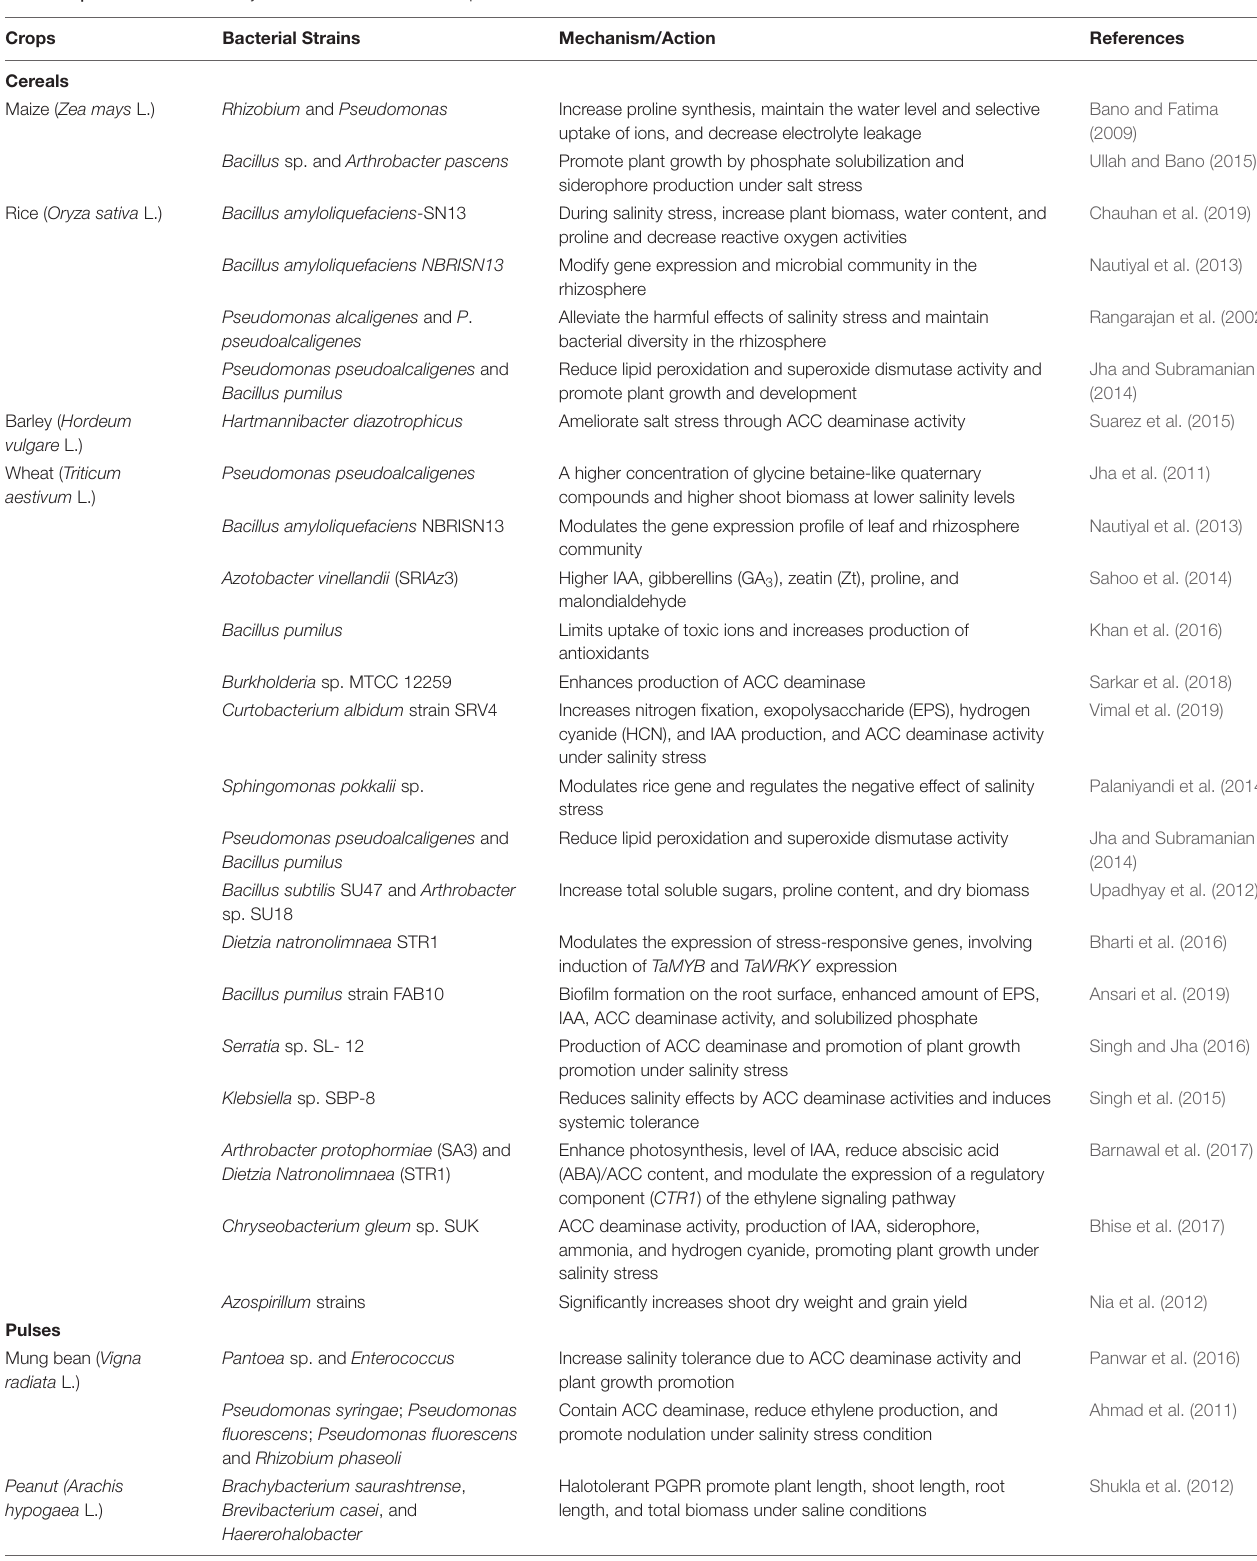
TABLE 1 | Mechanisms of salinity stress tolerance in different plants.